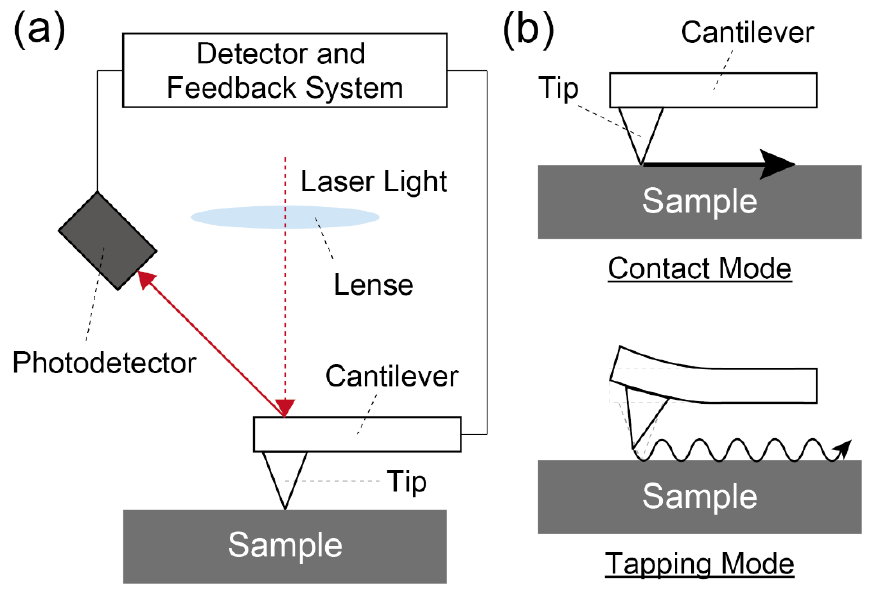
Figure 6. ( a ) Schematic representation of an AFM measurement setup. ( b ) Example illustrations of each measurement mode of the AFM.